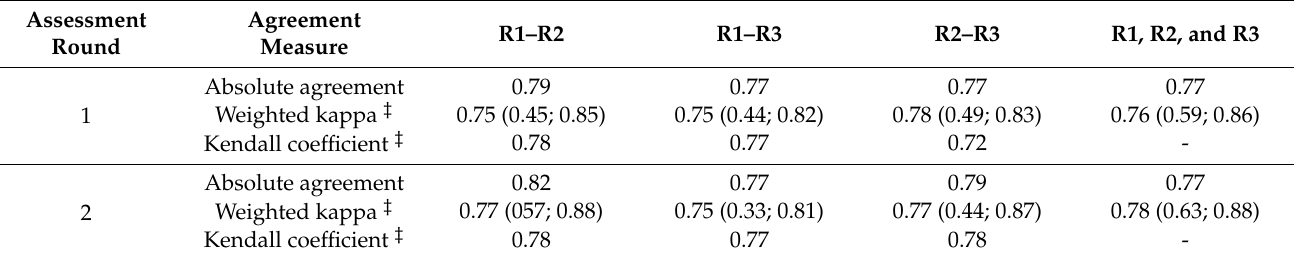
Table 4. Analysis of inter-rater agreement in the two study